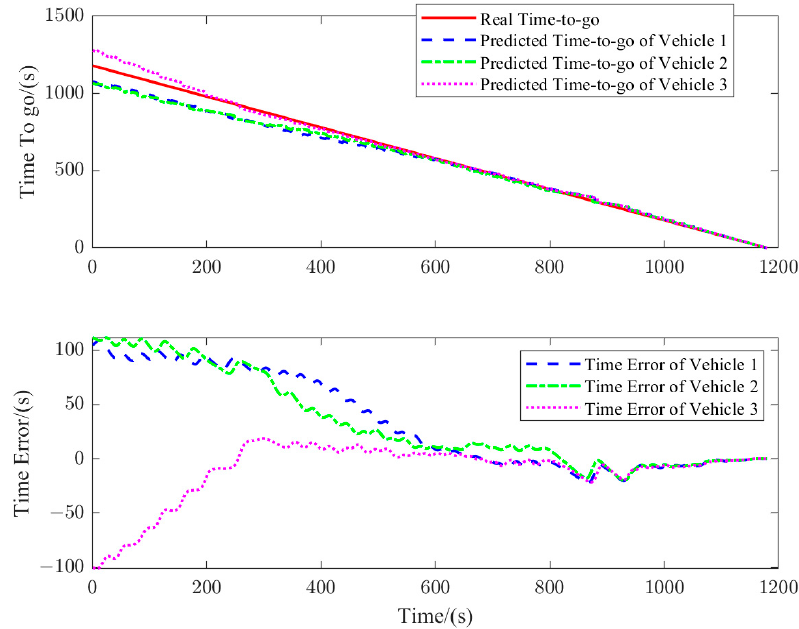
Figure 10. The prediction of residual flight time of the three vehicles.